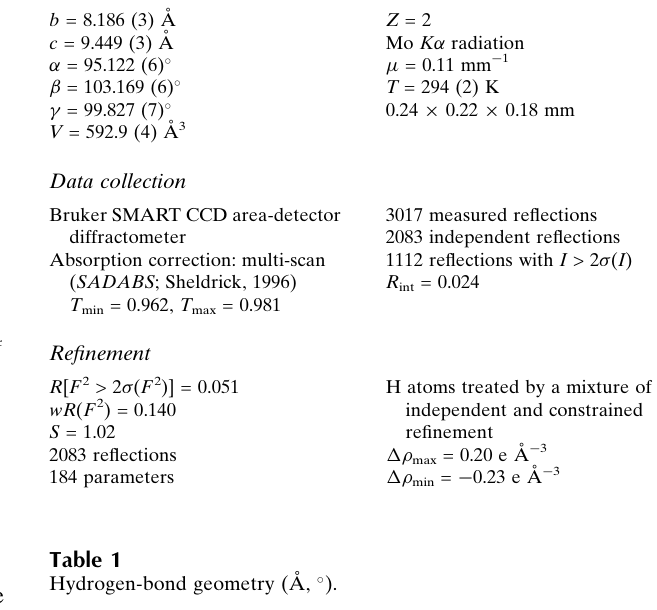
Hydrogen-bond geometry (A˚ , (cid:2) ). D —H (cid:1)(cid:1)(cid:1)